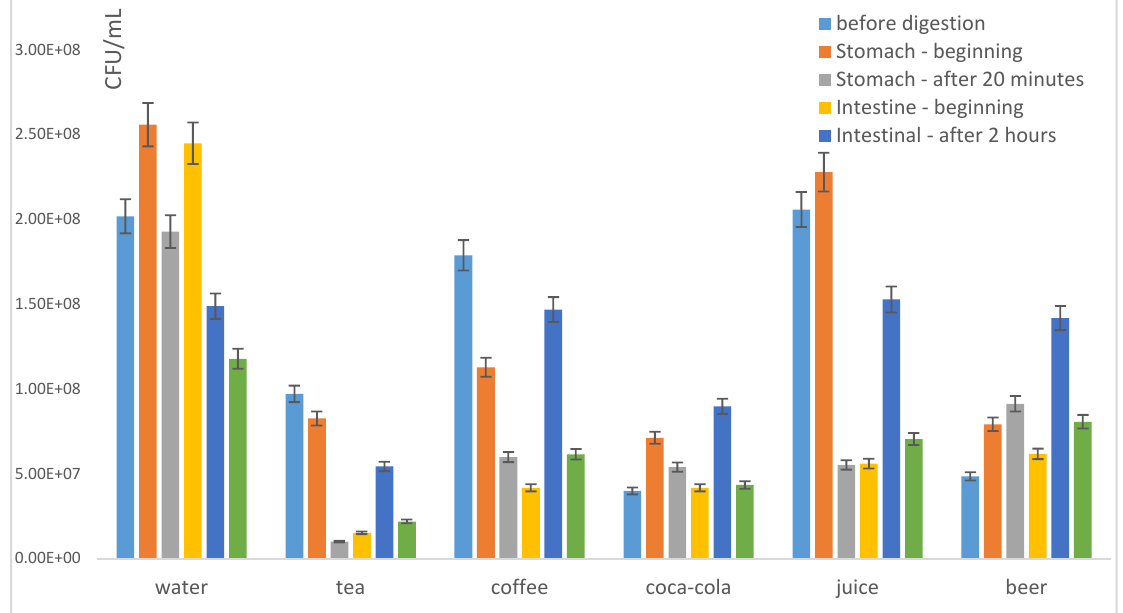
Figure 4. Viability of mixed probiotic culture in selected beverages during the gradual process of model digestion.